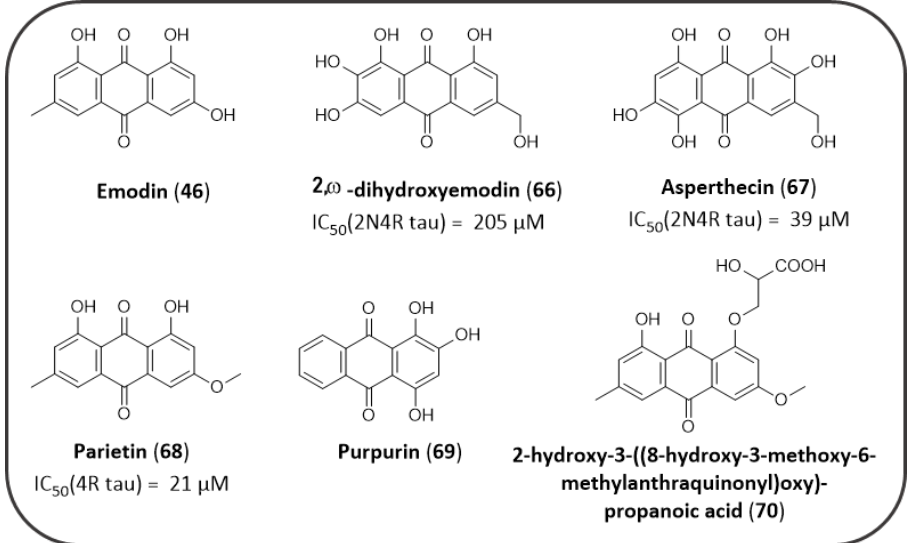
Figure 14. Natural derived AQs as tau aggregation inhibitors.